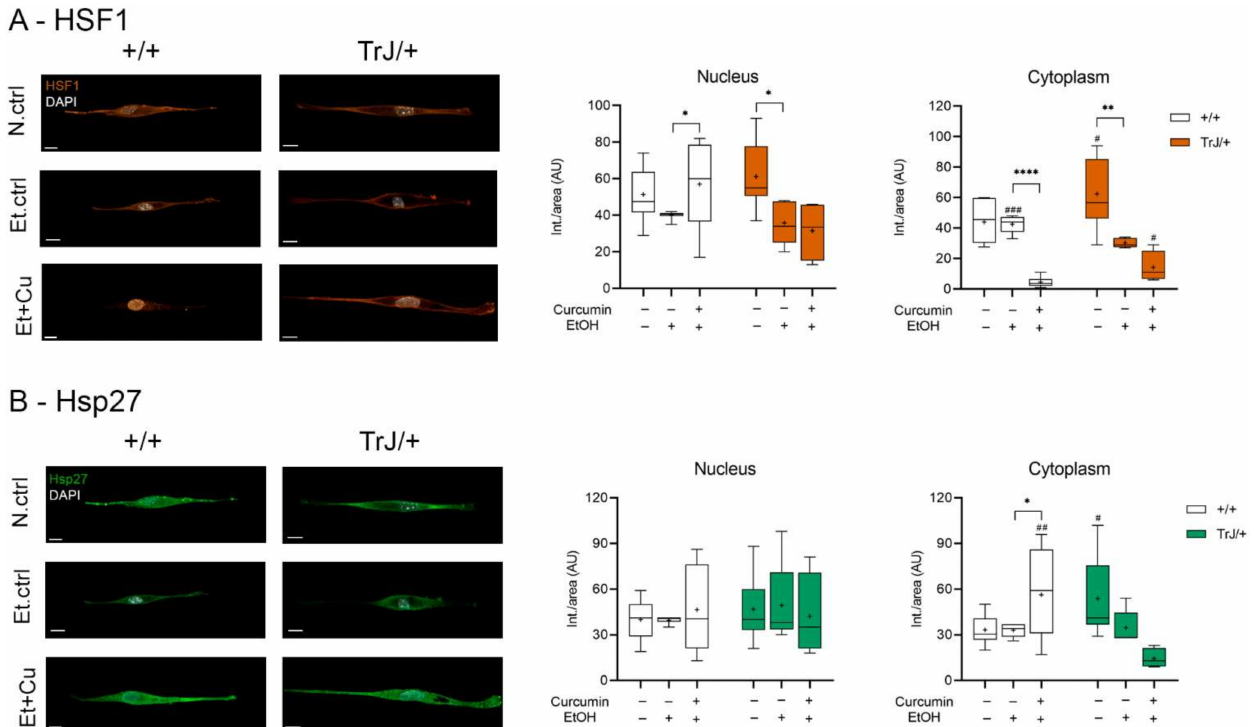
Figure 5. Modulation of HSF1 and Hsp27 expression levels in +/+ and TrJ/+ SCs enriched cultures. Images obtained by confocal microscopy of +/+ and TrJ/+ SC N.ctrl, E.ctrl, and Et+Cu were quantified in the nucleus and cytoplasm. ( A ) HSF1 expression. Et.ctrl vs. N.ctrl had a decrease only in TrJ/+ SC in both compartments. Et+Cu treatment vs. Et.ctrl showed a nuclear increase and a cytoplasmic decrease only in +/+ SCs. In turn, the comparison +/+ vs. TrJ/+ SCs of the same condition revealed only cytoplasmic differences in Et.ctrl and Et+Cu; ( B ) Hsp27 expression. No differences were observed between Et.ctrl vs. N.ctrl, in both genotypes or both compartments. A comparison +/+ vs. TrJ/+ SCs of the same condition revealed cytoplasmic differences in N.ctrl and Et.ctrl. Within each genotype: * p < 0.033, ** p < 0.002 and **** p < 0.0001. Same treatment between +/+ and TrJ/+: # p < 0.033, ## p < 0.002 and ### p < 0.0001. The mean is shown as “+”. Scale = 10 µ m for all panels. n = 100 cells in average per condition for each